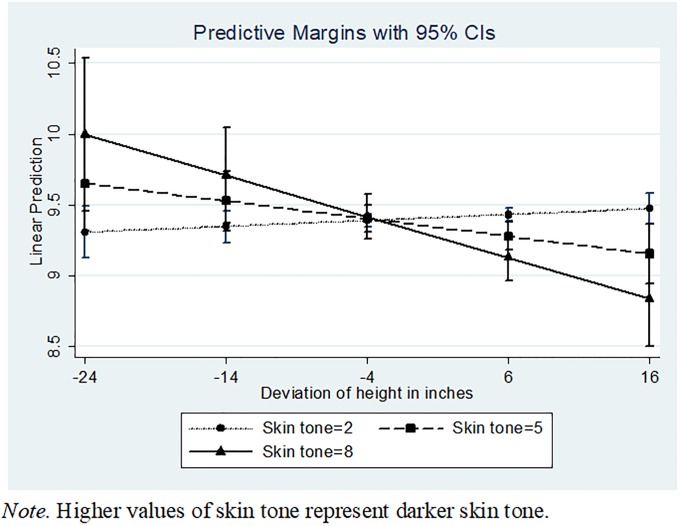
Three-way interaction between skin tone, height, and gender.Graphed lines indicate impact of skin tone and height on earnings for men.